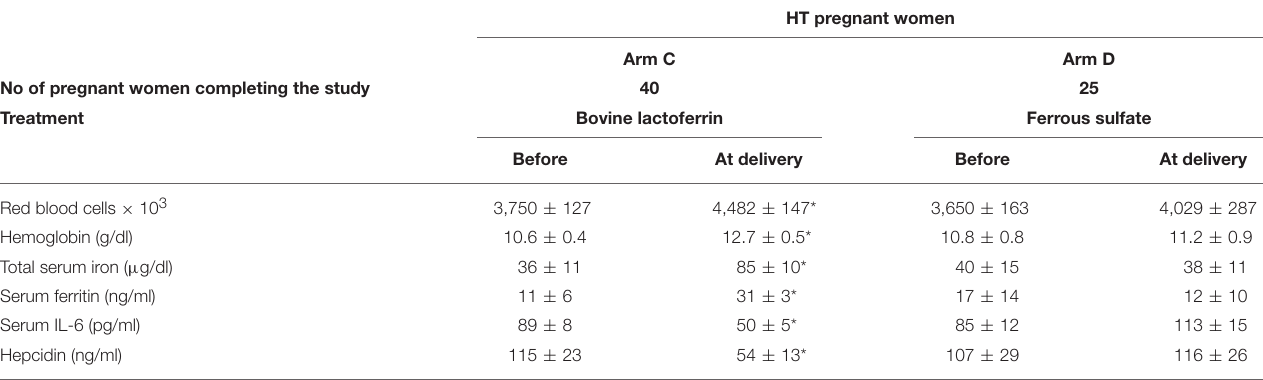
TABLE 7 | Hematological parameters, serum IL-6 and hepcidin mean values ± SD of HT pregnant women, suffering from AI, treated with bovine lactoferrin (Arm C) or with ferrous sulfate (Arm D), before the treatment and at